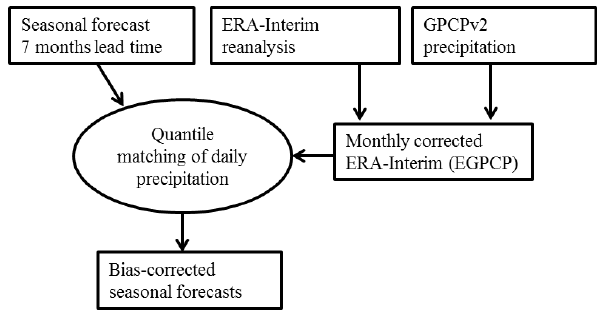
Figure 3. Flowchart of the bias correction of the seasonal